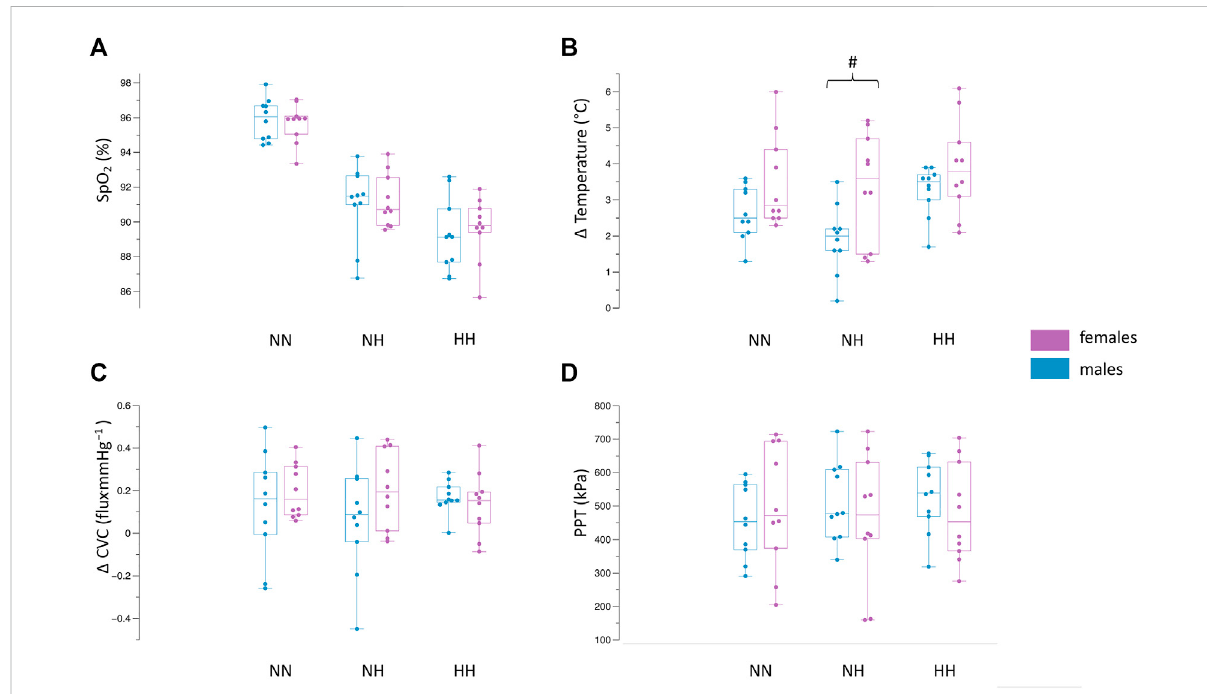
FIGURE 2 Differences between females and males in NN, NH and HH for SpO2 (A) , Δ skin temperature (B) , Δ CVC (C) , PPT (D) . Values demonstrate the median, iqr, min, max values. Dots indicate the individual values of each participant. # p = 0.01 between females and